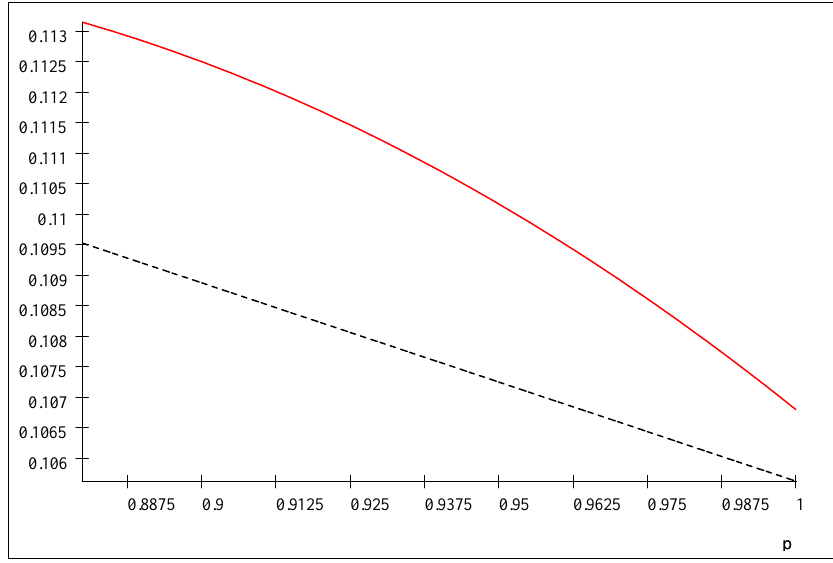
Figure 5. a = 1 , (cid:12) = 0 : 1 . x-axis-probability of campaign success (cid:25) . y-axis: solid line- (cid:133)rm Figure 5. a = 1, β = 0.1. x-axis-probability of campaign success π . y-axis: solid line- firm payoff in payo⁄ in case (CF,CF); dash line- Firm 1 payo⁄ in case (S,CF). case (CF,CF); dash line- Firm 1 payoff in case